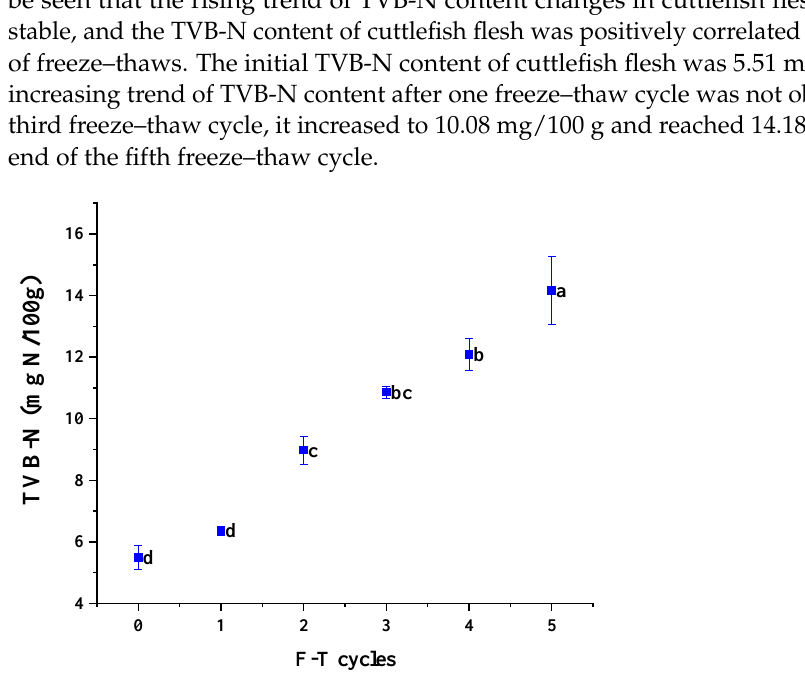
Figure 8. The content of TVB-N of cuttlefish after freeze–thaw cycles. Error bars show standard deviation. The letters “a–d” indicate significant differences ( p < 0.05).